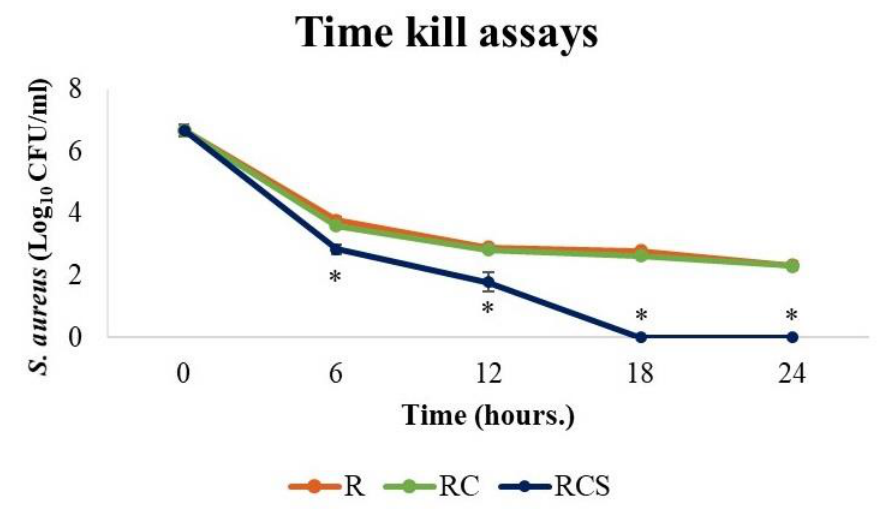
Figure 3: The trend of S. aureus suppression of the supernatants during 0 to 24 hours. R: supernatant of Rich medium only, RC: supernatant of Rich medium-plus VCO (2.5% v/v), and RCS: supernatant of Rich medium-plus VCO (2.5% v/v) plus S. epidermidis (10 6 CFU/ml). The RCS supernatant showed an efficient antimicrobial